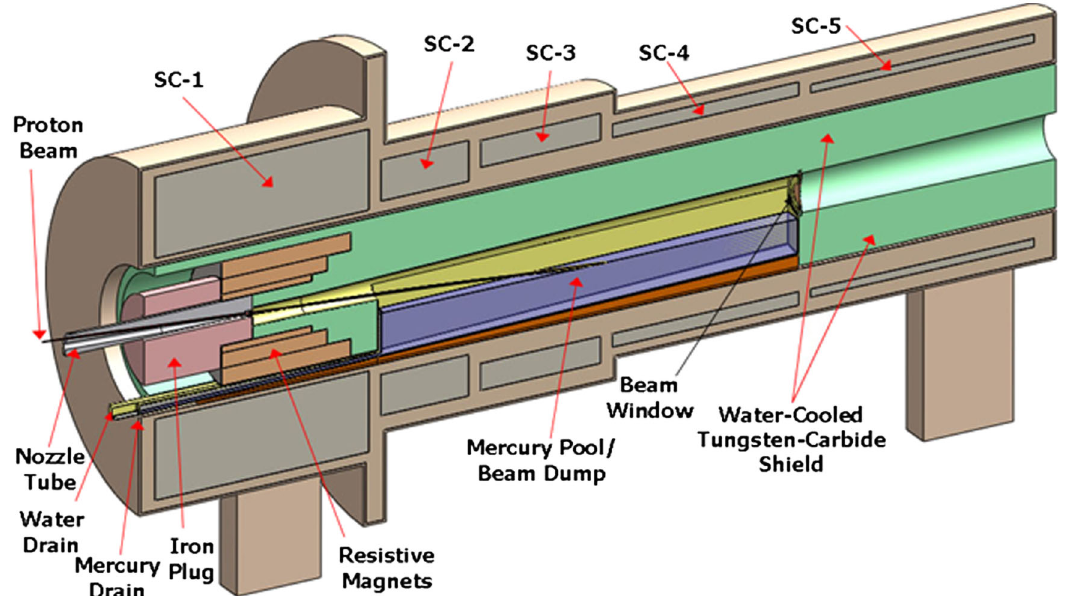
FIG. 9. Conceptual layout of the Neutrino Factory pion production target and capture system.